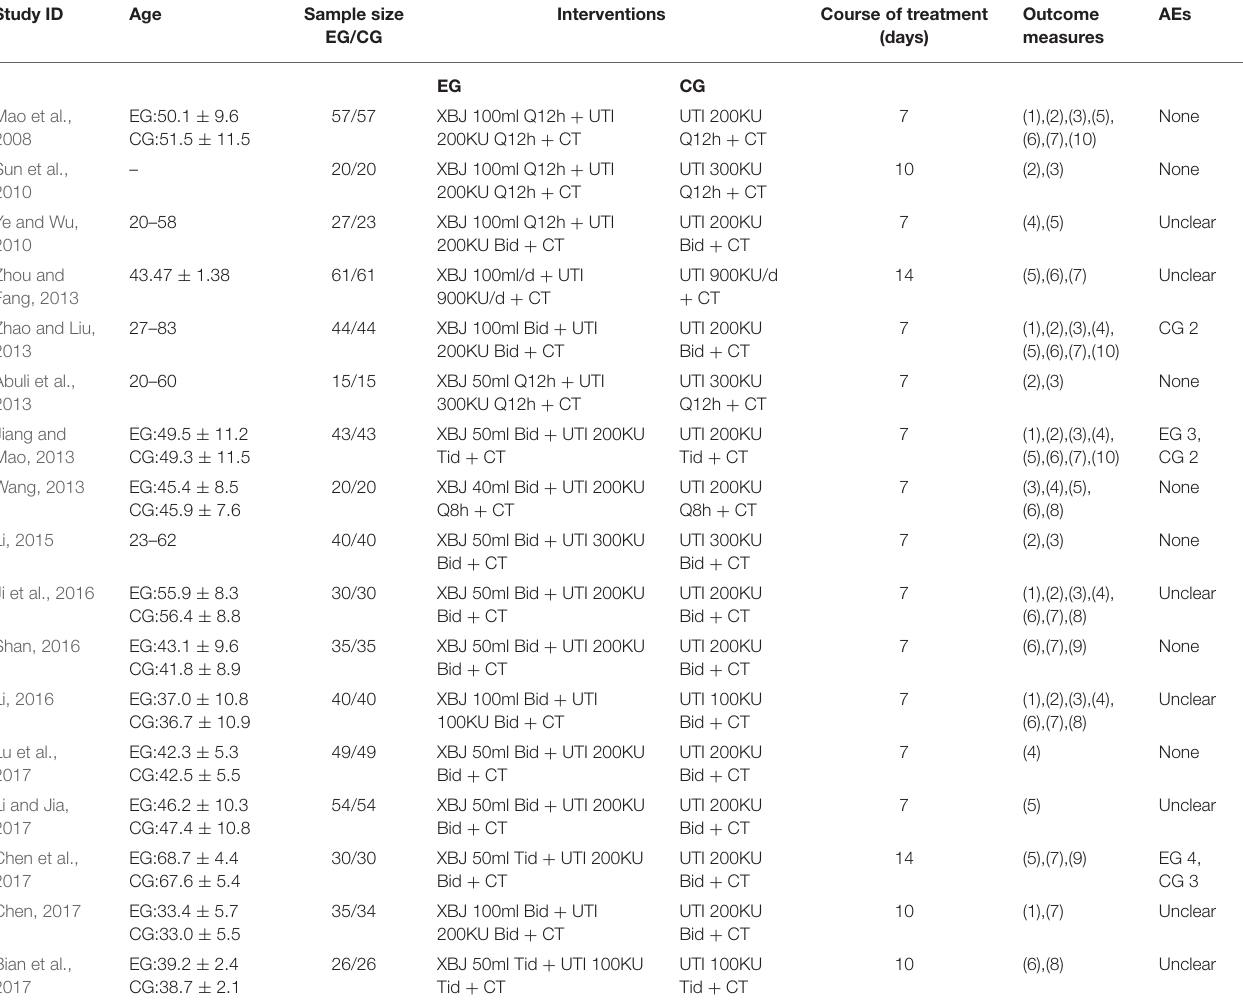
TABLE 1 | Characteristics of the included